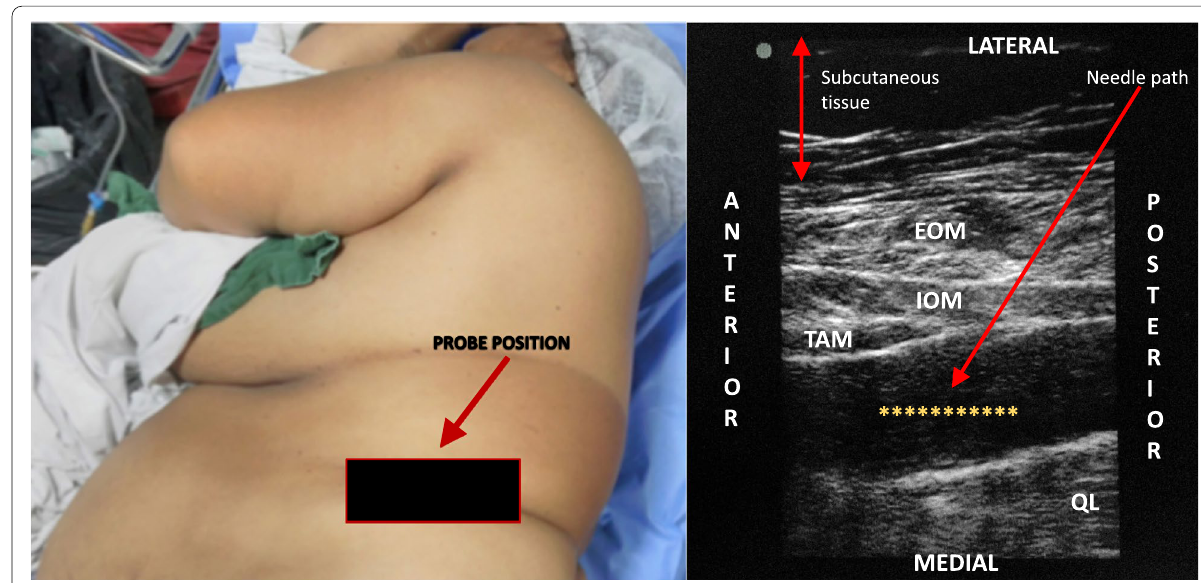
Fig. 1 a Patient positioned lateral and high‑frequency probe placed transversely over the flanx. b Needle path and local anesthetic deposit anterolateral to quadratus lumborum (QL) muscle EOM—external oblique, IOM—internal oblique, TAM—transverse abdominis muscle, *****—local